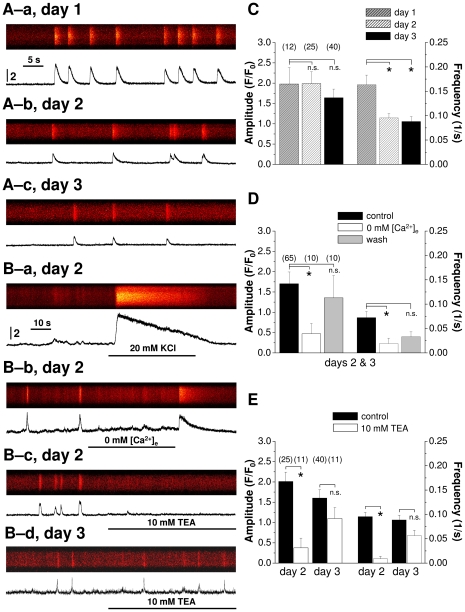
Spontaneous changes in [Ca2+]i and effects of different ion composition and TEA on spontaneous calcium events in cells of HDC.(A) Representative line-scan images showing spontaneous changes in [Ca2+]i on various days of culturing. Images were recorded at 7 ms/line, 512 pixels/line. (B) Representative line-scan images recorded on days 2 and 3 demonstrating the effects of the ion milieu or TEA application on spontaneous Ca2+ events. Images were acquired at 14 ms/line and 512 pixels/line. Horizontal lines indicate the application of different solutions. For panels (A) and (B), traces below the images are spatially averaged time courses of Fluo-4 fluorescence normalized to baseline fluorescence (F/F0). Vertical calibrations are the same for all images and for all traces in panels (A) and (B). (C) Pooled data for the amplitude and frequency of spontaneous calcium transients measured in normal [Ca2+]e (1.8 mM) on different days of culturing. Asterisks (*) mark significant (p<0.05) differences between frequencies on different days of culturing as compared to day 1. Pooled data of the effects of (D) Ca2+-free milieu (days 2 and 3) and (E) 10 mM TEA (on day 2 and on day 3) on the amplitude and frequency of spontaneous calcium transients. Asterisks (*) indicate significant (p<0.05) differences between control and treated cells. Numbers above diagrams represent the number of cells measured during each measurement. Data represent mean ± standard error (SE) of the mean.